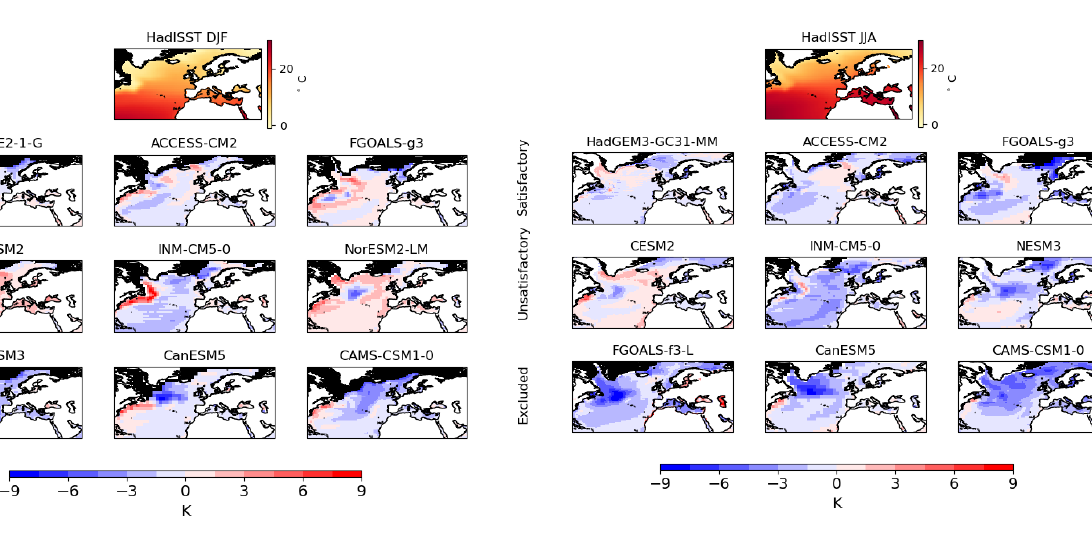
Figure A2. Model SST bias (compared to HadISST) for DJF. Sea- sonal average calculated for a 20-year climatology (1995–2014). Areas where the model SST < 0 ◦ C are masked in black (this was found to approximate 5% ice concentration). Top row shows the HadISST and 5% ice concentration field.